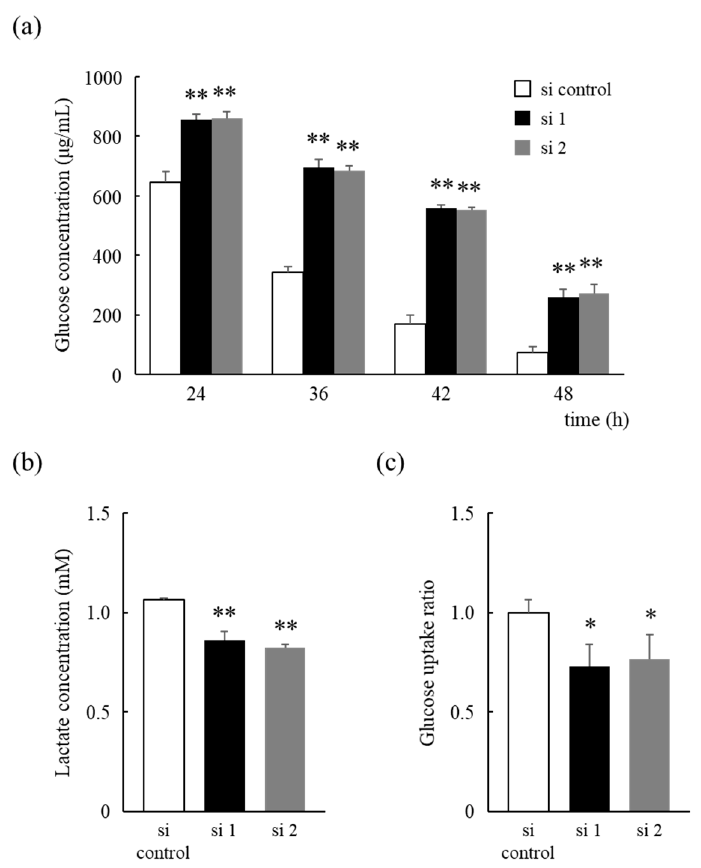
Figure 5. Suppression of glucose consumption and lactate production in HNRNPM knockdown cells. ( a ) Cells were pre-treated with an siRNA against HNRNPM or a non-targeting siRNA and incubated for 24 to 48 h under low-glucose conditions. The glucose concentration in the medium was determined using the Glucose kit Glucose C II Test Wako. ( b , c ) Cells were pre-treated with an siRNA against HNRNPM or a non-targeting siRNA, and incubated for 48 h under low-glucose conditions. The lactate concentration in the medium was determined using the Glycolysis Cell- Based Assay Kit ( b ). Glucose uptake was determined using the Glucose Uptake-Glo Assay and the CellTiter-Glo 2.0 Cell Viability Assay ( c ). Data are shown as mean ± SD (n = 3); *, p < 0.05; **, p < 0.01 compared to each si control. si control: non-targeting siRNA-transfected cells, si 1: HNRNPM siRNA (SASI_Hs01_00049126)-transfected cells, and si 2: HNRNPM siRNA (SASI_Hs01_00049128)-transfected cells.